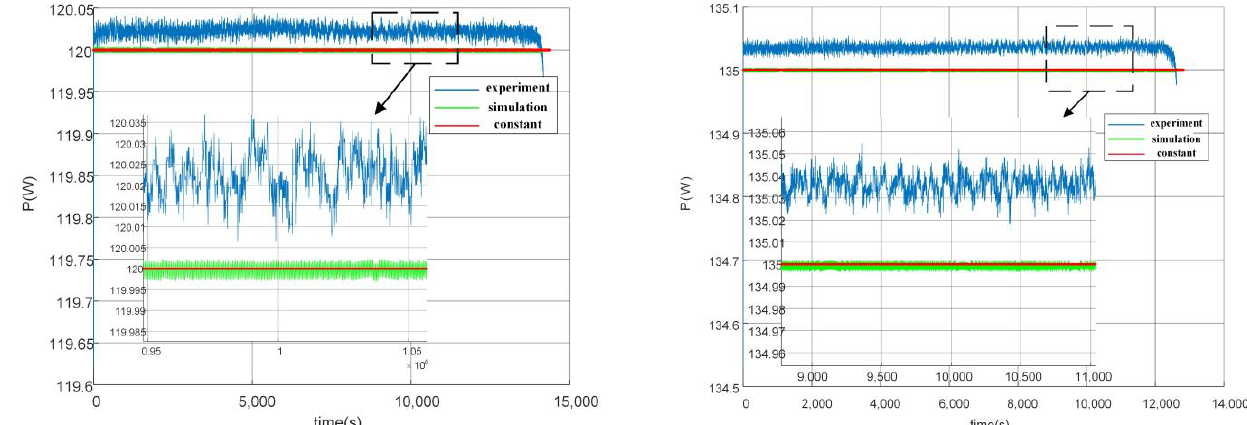
Batteries 2022 , 8 , x FOR PEER REVIEW Figure 10. Comparison chart of power at 120 W ( left ) and 135 W ( right ). Figure 10. Comparison chart of power at 120 W ( left ) and 135 W ( right ).